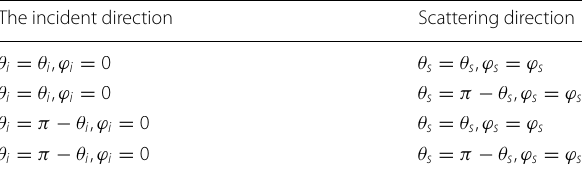
Table 1 Observation angles combinations as for the phase matrix